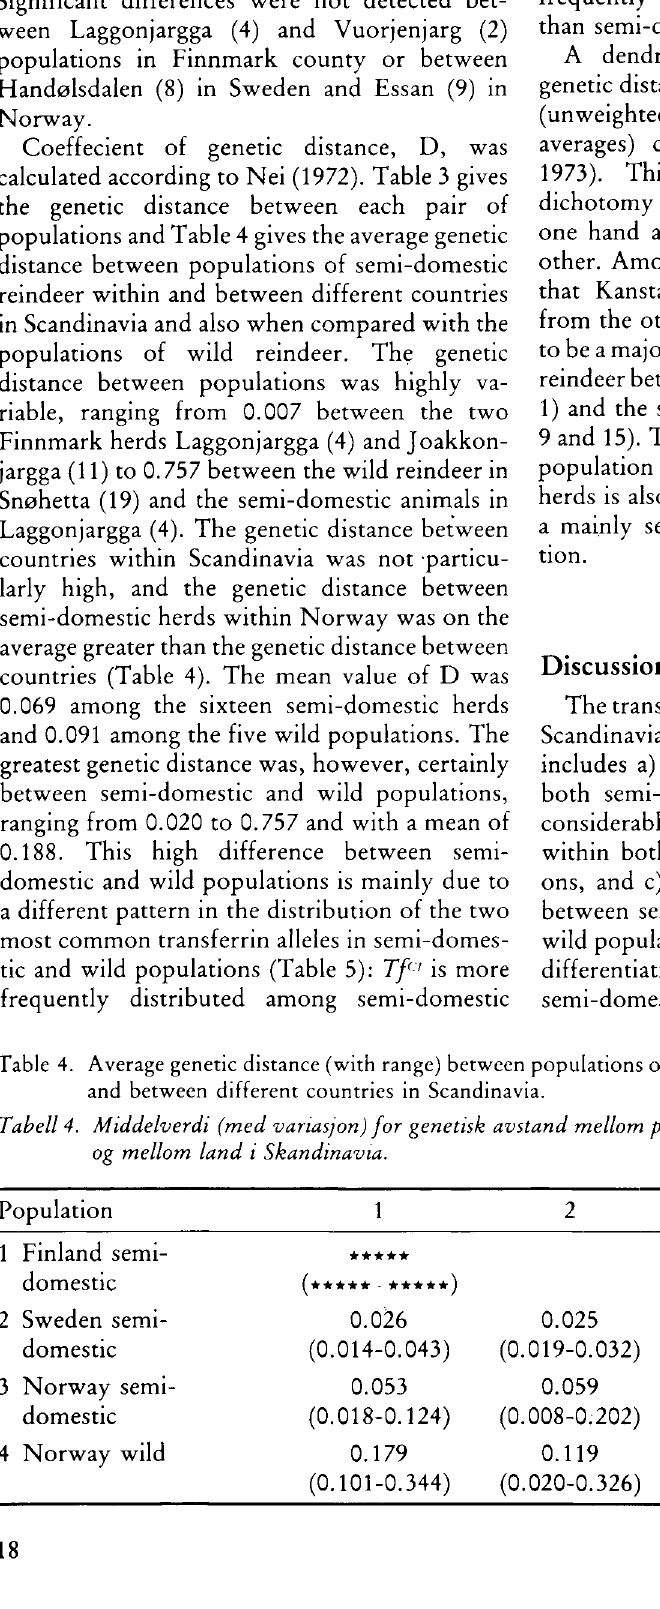
Table 4. Average genetic distance (with range) between populations of semi-domestic and wild reindeer within and between different countries in Scandinavia. Tabell 4. Middelverdi (med variasjon) for genetisk avstand mellom populasjoner av tamrein og villrein innen og mellom land i